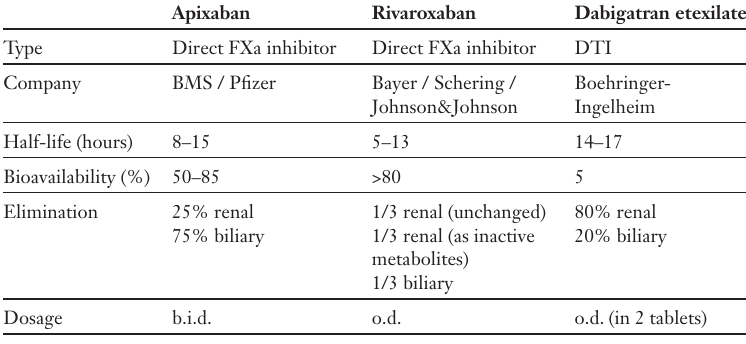
Comparison of three upcoming novel oral